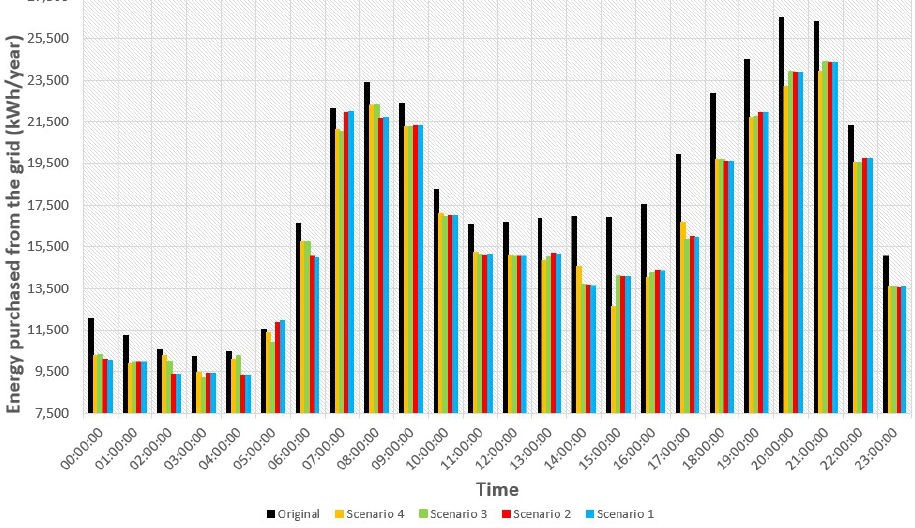
Figure 8. Energy purchased from the grid for the scenarios